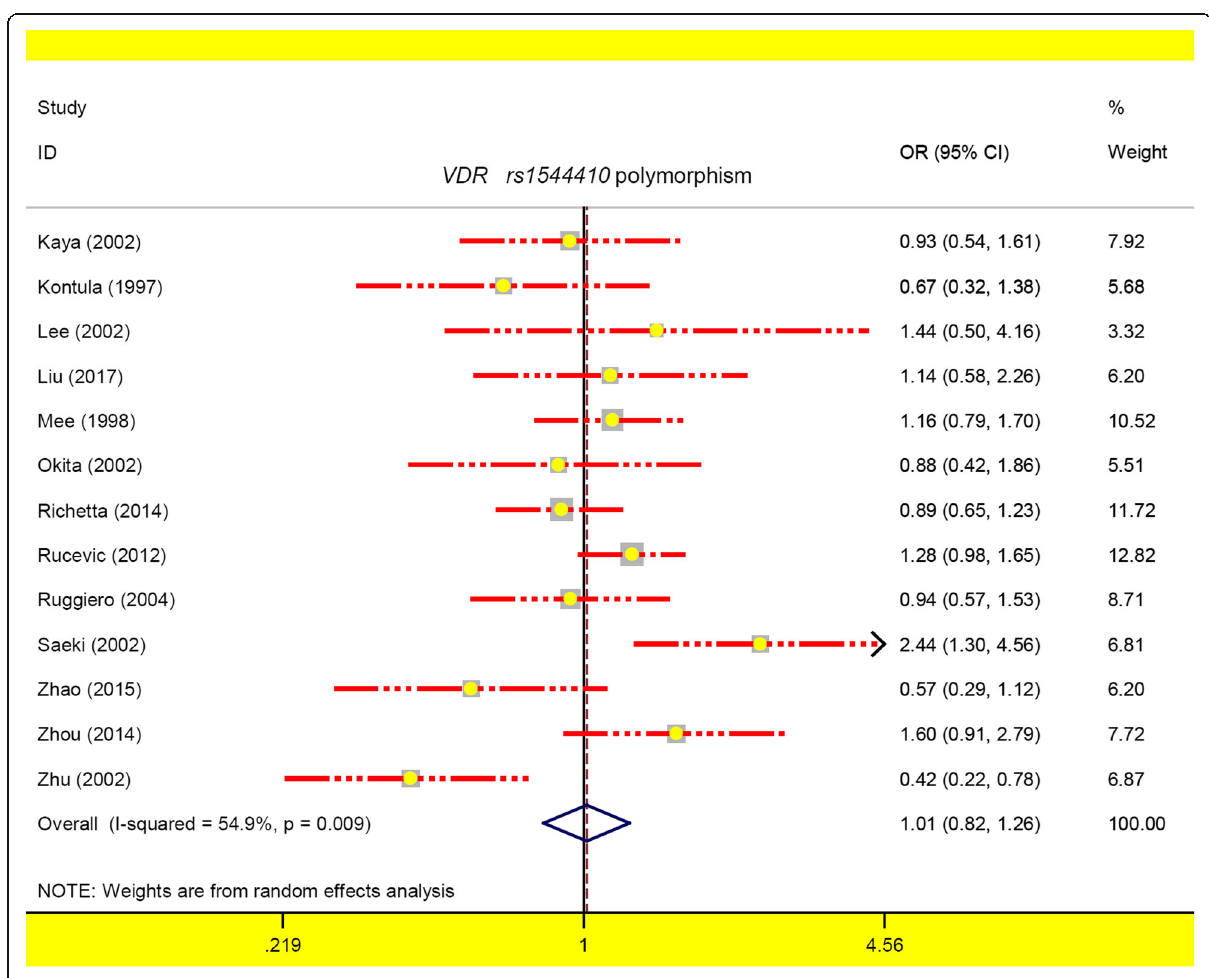
Fig. 3 The forest plot for VDR rs1544410 polymorphism under the allele